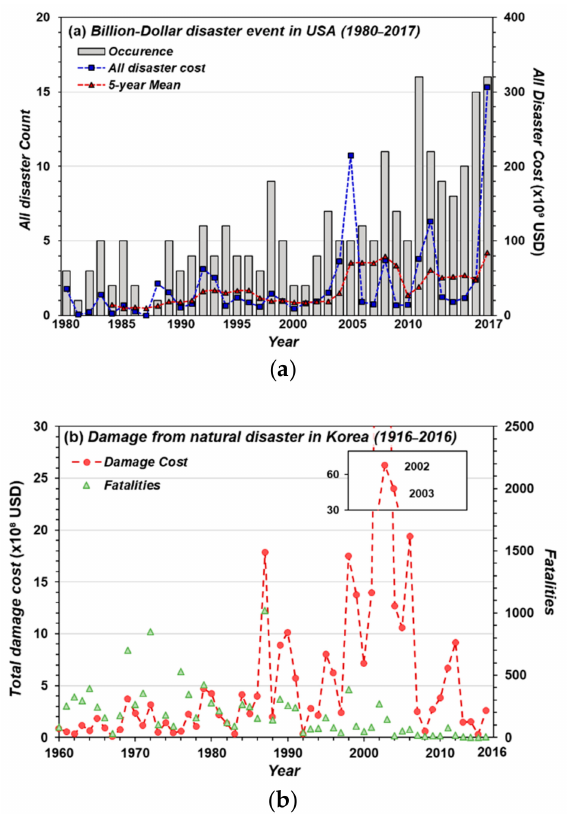
Figure 3. Disaster occurrences, including flooding, severe storms, drought, tropical cyclones, winter storms, freezing, and wildfire, with relevant damage costs: ( a ) The U.S. billion-dollar disaster record (1980–2017). Reproduced with permission from the National Oceanic and Atmospheric Administration (NOAA) of the United States, U.S. Billion-Dollar weather and climate disasters (https: // www.ncdc.noaa.gov / billions / time-series); published by National Centers for Environmental Information (NCEI) [19]; ( b ) Total disaster damage cost and fatalities in South Korea (1916–2016). Reproduced with permissions from 1) Ministry of the Interior and Safety, Annual Disaster Report 2016; published by the Ministry of the Interior and Safety of the Republic of Korea Government, 2017 [20], and 2) National Emergency Management Agency, Annual Disaster Report 2009; published by National Emergency Management Agency of the Republic of Korea Government, 2010